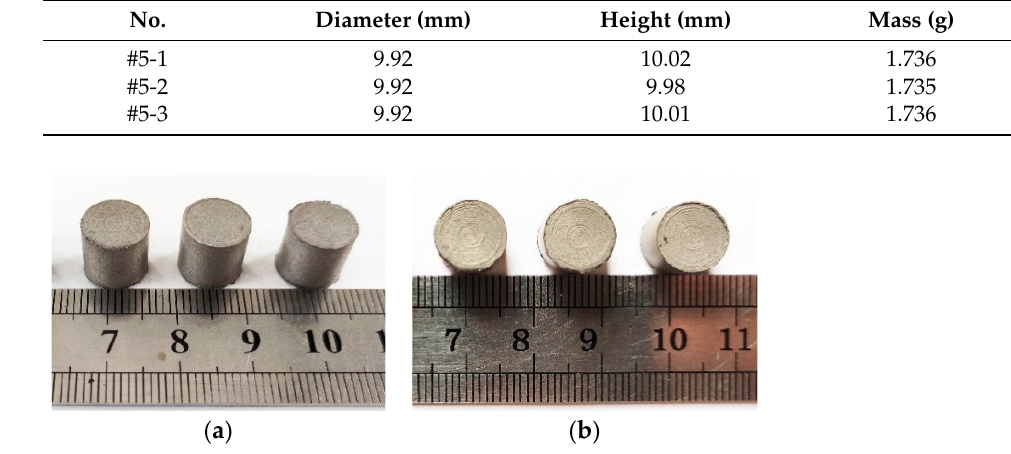
Figure 1. Physical samples of PTFE/Al/Si reactive material samples: ( a ) Front view; ( b ) Vertical view. By processing the experiment data, the pressure-displacement curves of PTFE/Al/Si samples were obtained as shown in Figure 2. According to the Formulas (2) and (5), the engineering stress − strain curves and real stress − strain curves of PTFE/Al/Si samples were further obtained, as shown in Figures 3 and 4, respectively. In addition, three PTFE/Al/Si samples recovered after the quasi-static compression test are shown in Figure 5.